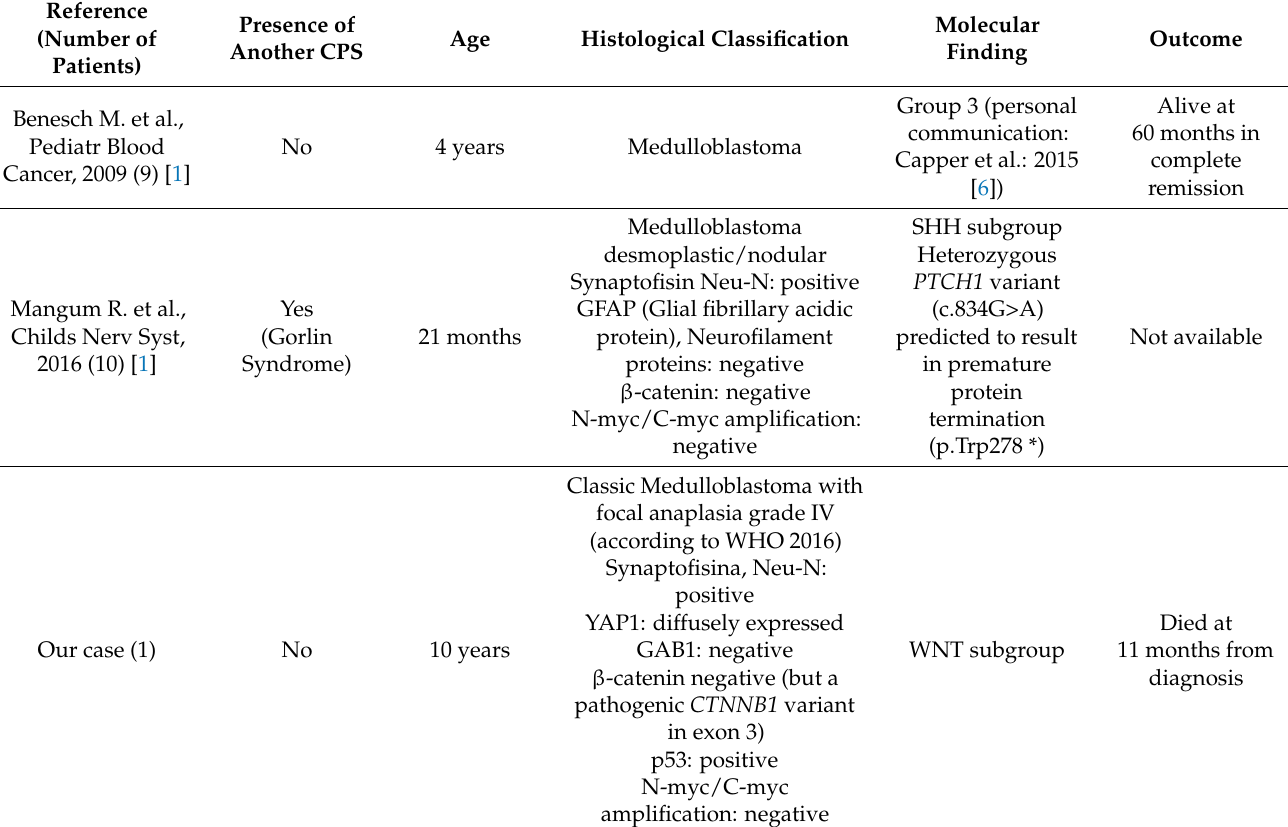
Table 2. Medulloblastoma in the Down syndrome (DS) population in